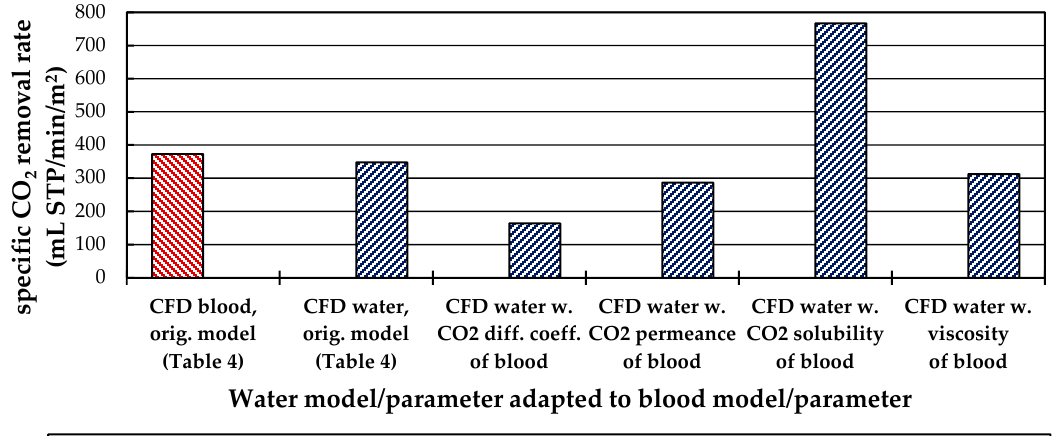
Figure 21. Influence of CO 2 diffusion, CO 2 permeance CO 2 solubility, and viscosity model on the CO 2 removal rate.